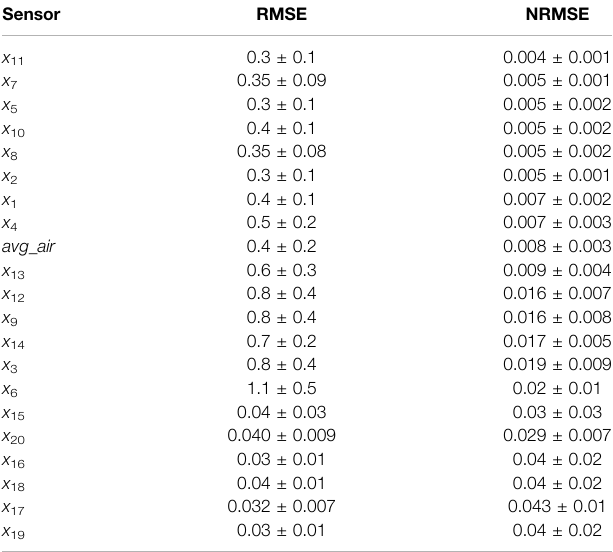
TABLE 5 | Performance of ML model in terms of error for each sensor ordered according to mean NRMSE. Average air temperature (avg_air) is based on comparingtheaverageofhead,torsoandfootairtemperaturesfordriverandfront passenger with that of the simulated values. Sensor RMSE